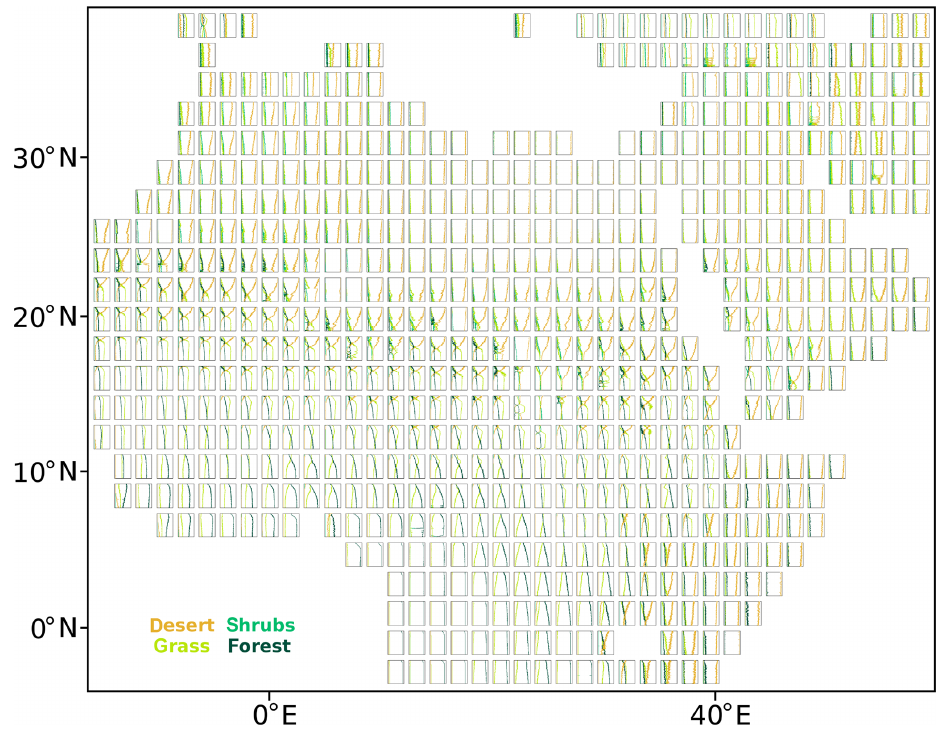
Figure B1. Simulated transient change in main PFT cover fraction (i.e. desert, grass, shrubs, and forest fraction) during the last 7850 years in each north African grid cell. The x axis of each individual plot displays the cover fraction ranging from 0 (left corner) to 1 (right corner); the y axis displays the time ranging from 8ka (bottom) to PI (top). A high-resolution version of this plot is provided in the